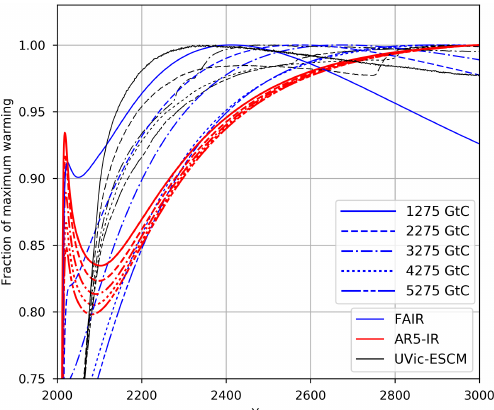
Figure 5. Dependency of the timing of maximum warming on pulse size. Global mean surface temperature response is expressed as a fraction of the maximum warming under the pulse experiments of Herrington and Zickfeld (2014). Responses are shown for the FAIR (blue), AR5-IR (red), and UVic ESCM (black). Different cumula- tive emission totals (see Herrington and Zickfeld, 2014) are denoted by different line styles.